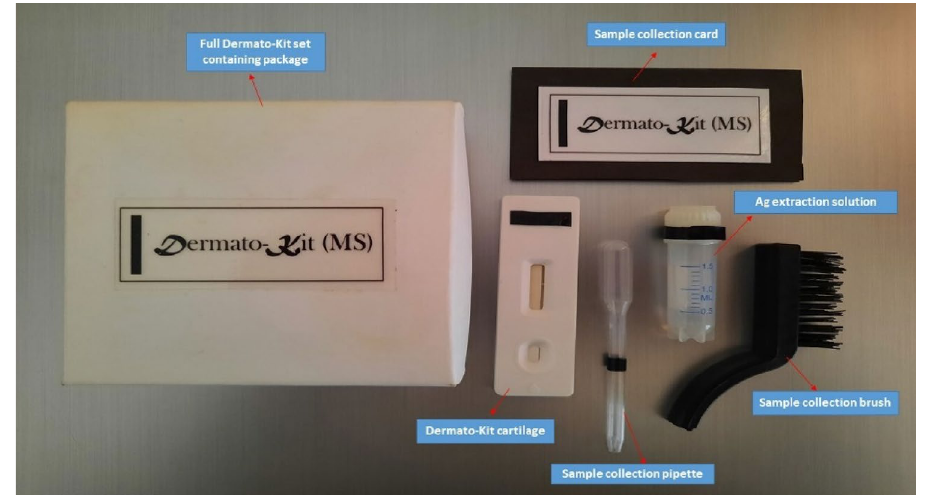
Figure 5. The newly developed Dermato-kit